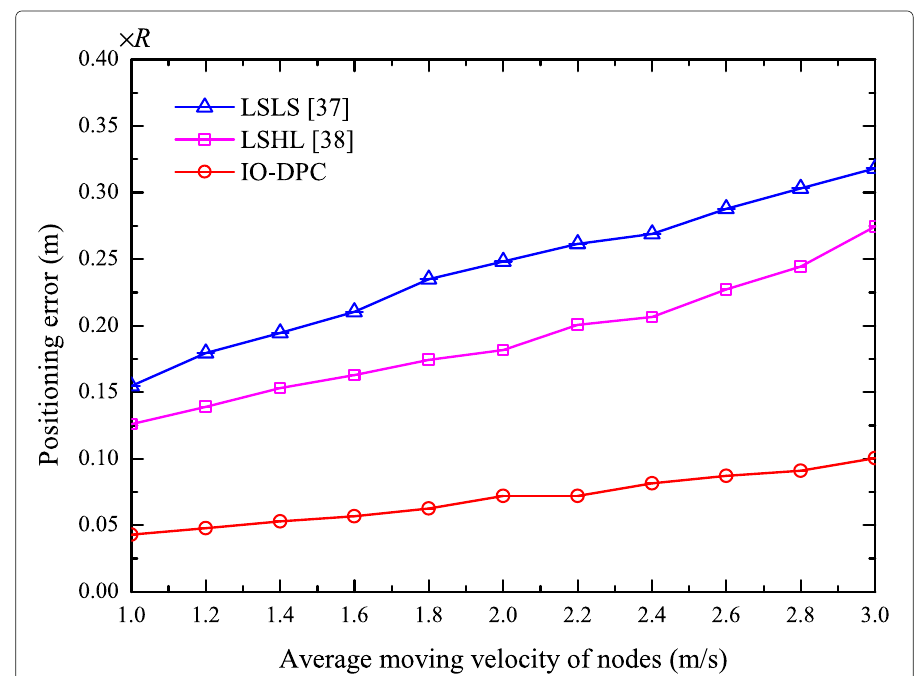
Fig. 11 Comparison of positioning error between IO-DPC and the other two